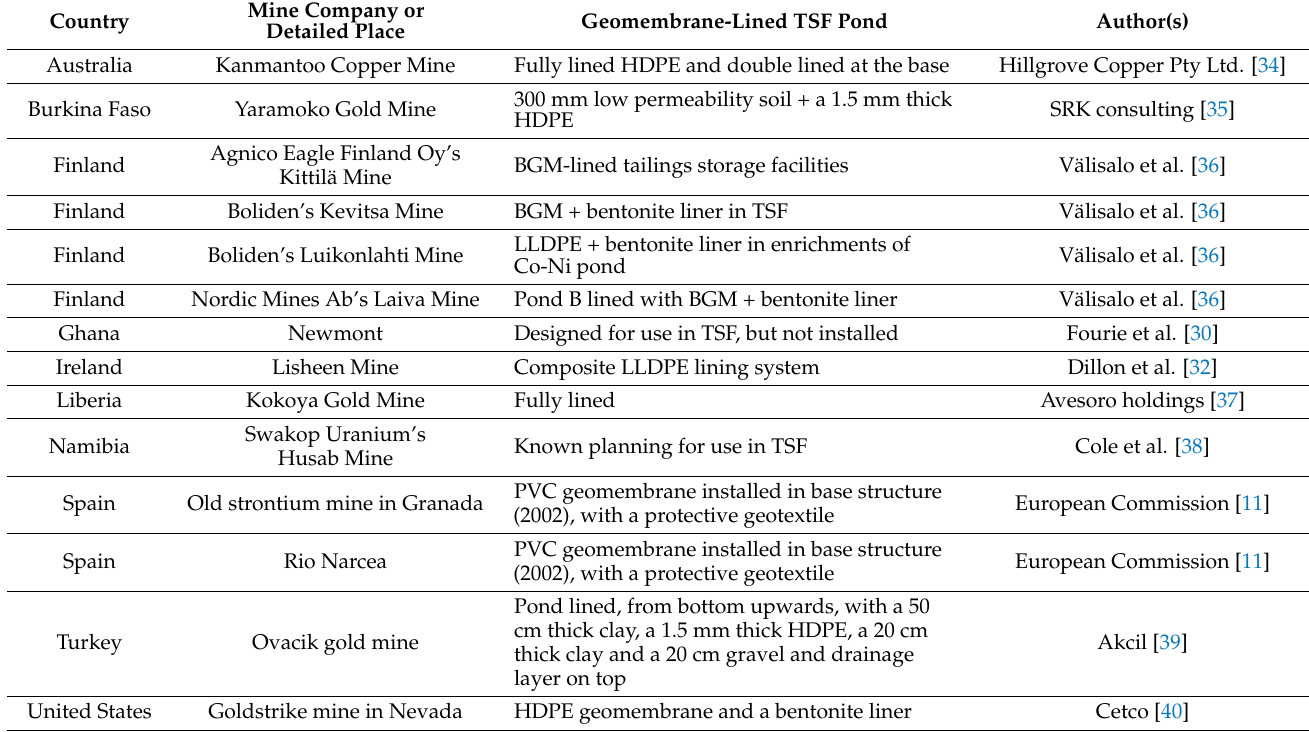
Table 1. Use of geomembranes in tailings storage facility (TSF) ponds around the world.